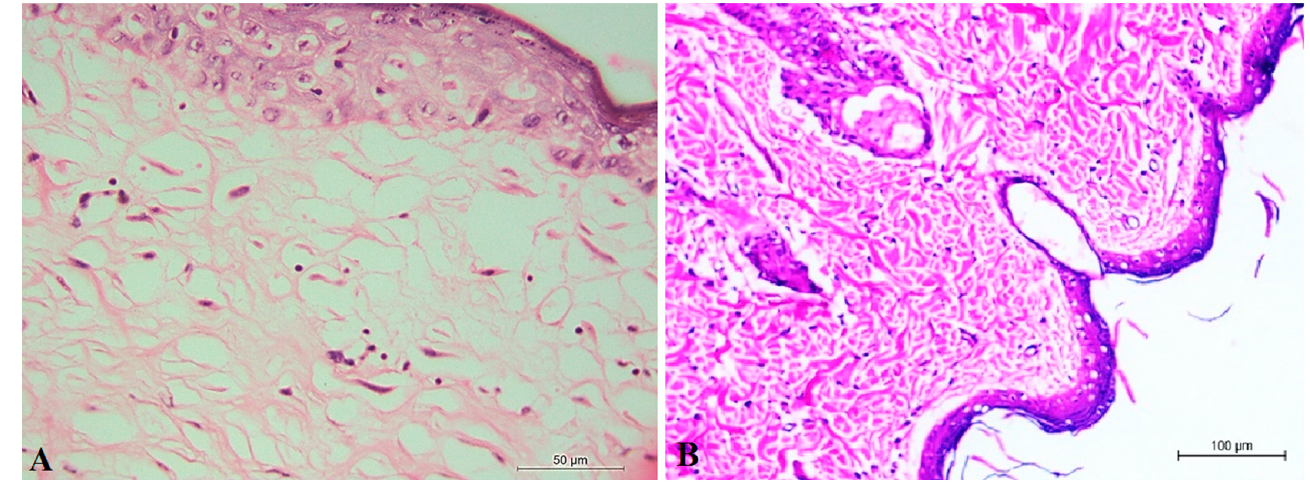
Figure 8. Histolopathological evaluation of negative control group (A) and optimum ALN gel (B).